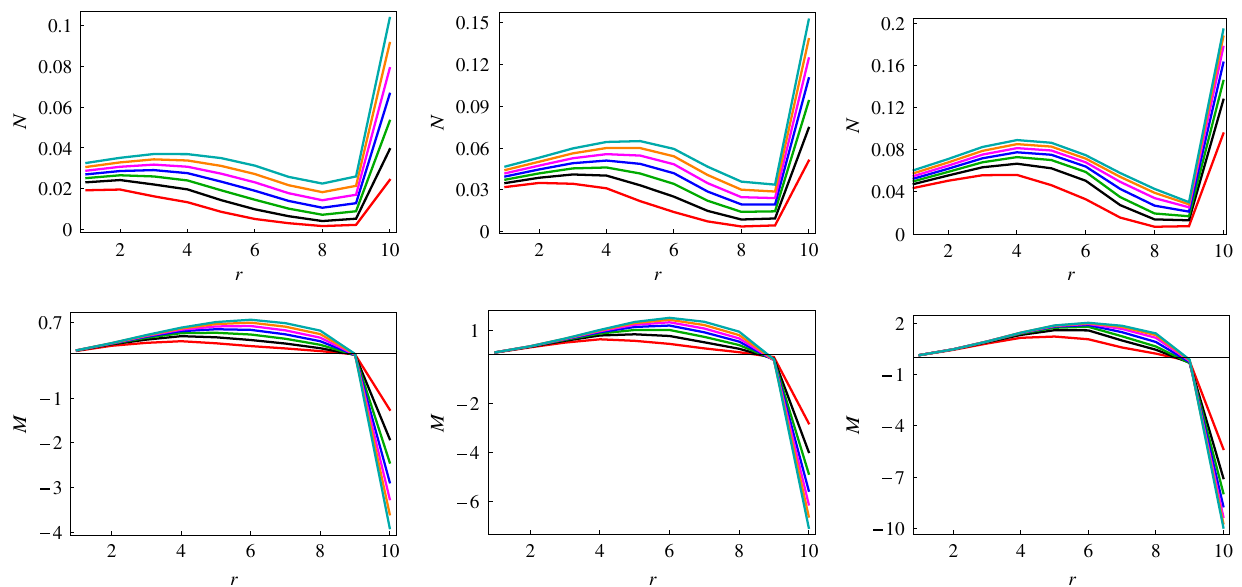
FIG. 3. Upper panels: Spatial variation of the local Néel order parameter ( N ), defined in Eq. (9), obtained from the self-consistent solution of the magnetic ground state, for various subcritical on-site Hubbard interaction and roughly uniform axial magnetic fields. The strength of the Hubbard interaction in each plot reads as U ¼ 0 . 1 (red line), 0.2 (black line), 0.3 (green line), 0.4(blue line), 0.5 (magenta line), 0.6 (orange line), 0.7(cyan line) from bottom to top. Strength of the uniform axial field reads as b ¼ 0 . 025 b 0 , 0 . 035 b 0 , 0 . 045 b 0 from left to right, where b 0 ¼ ℏ = ð ea 2 Þ ∼ 10 4 T is the axial field associated with the lattice spacing a ≈ 2 . 5 Å. Lower panels: Spatial variation of local ferromagnetic order parameter ( M ) obtained from the same self-consistent solution for the magnetic ground state. Here, N is the average Néel order parameter per unit cell, and M is the total magnetization, in a quasicircular ring.